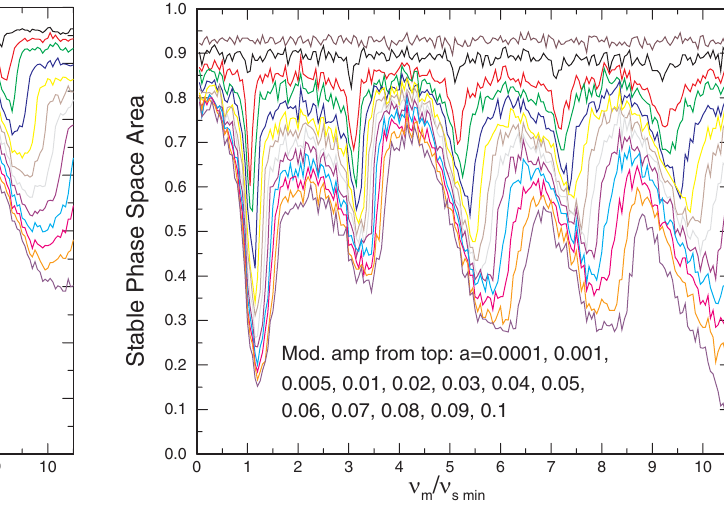
FIG. 10. (Color) Fractional stable bunch area in ratio to the bucket area as functions of phase modulation tune, for fractional modulation amplitudes, from top to bottom, a (cid:1) 0 : 0001 , 0.001,